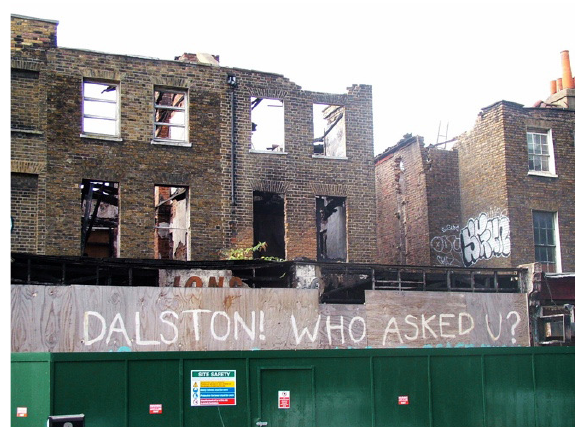
Figure 1. Key moment during the Dalston Lane contro‐ versy: Demolition of historically significant examples of early 19th century Georgian terraces on Dalston Lane after years of neglect and fire damage, 2007. Source: OPEN Dalston (2007b).